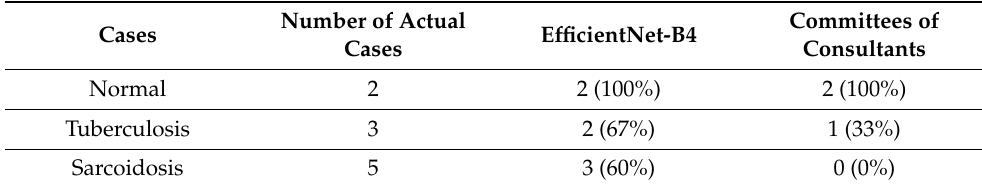
Committees of Consultants